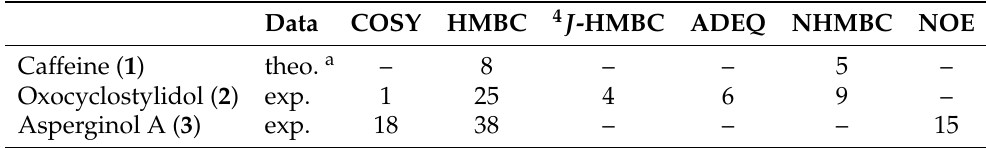
Figure 2. Structures of the investigated molecules 1 – 3 . For oxocyclostylidol ( 2 ) the observed HMBC correlations over four bonds are indicated as red arrows. Table 1. Correlation data (number of correlations) of the investigated molecules 1 – 3 .